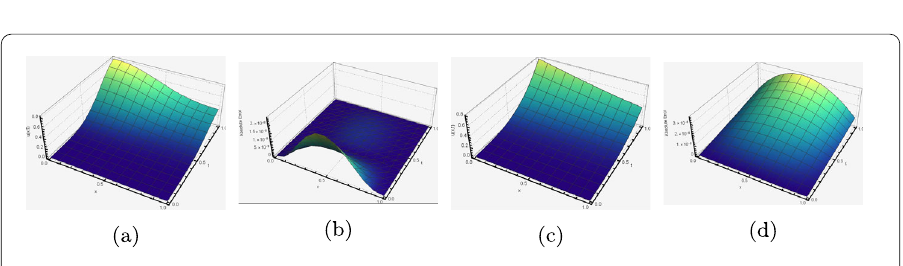
Figure 2 ( a ) and ( b ) represent approximate solution and absolute error distribution, respectively, using SJSCM. ( c ) and ( d ) represent approximate solution and absolute error distribution, respectively, using the